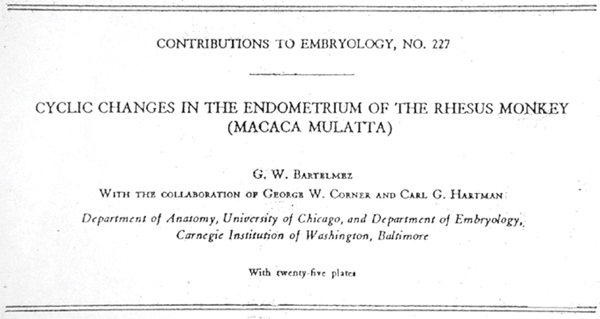
Studies by Bartelmez on the histological paramenters of the rhesus monkey throughout the menstrual cycle. [12]. These studies defined histological zones in the endometrium. Note that the collaborators include George.W. Corner and Carl G. Hartman.